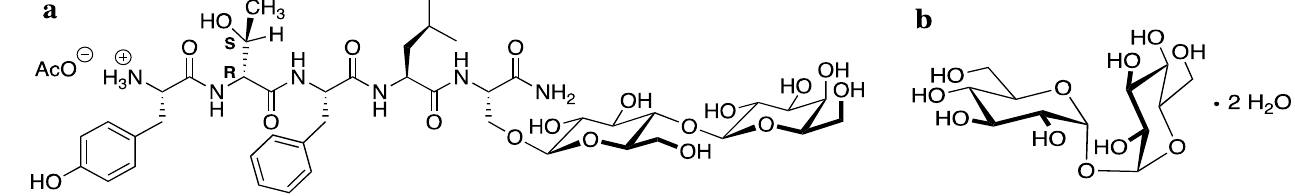
Figure 1. The chemical structures of Lactomorphin/MMP2200 ( a ), and Trehalose dihydrate ( b ). The brain is a unique and complex organ that is highly protected and isolated from the systemic circulation by two major barriers, the BBB and the blood-cerebrospinal fluid barrier (BCSFB) [5]. The BBB’s functional unit includes the capillary endothelial cells, pericytes, and perivascular astrocytes in constant and close contact with the endothelium. These anatomical features and the interaction of these cells support the brain capillary phenotype [5]. The BBB’s endothelial cells are different from the corresponding cells in the periphery in they have minimal pinocytotic activity, increased mitochondrial content, a lack of fenestrations, and the presence of tight junctions [6,7]. The BBB is a barrier for many therapeutics in drug development [8]. The intranasal (IN) route is one of the most promis- ing strategies to deliver drugs non-invasivelyto the brain [8]. Several mechanisms of drug transport through the olfactory epithelium are known and include the transcellular route (i.e., through the cells), the paracellular route (i.e., between the cells), and through the olfac- tory neuronal cells by intracellular axonal transport [9]. The nasal route of administration has many advantages including low dose, higher local bioavailability in the CNS, bypass- ing the BBB, shorter time to drug onset, non- invasiveness, and self-administration [10]. Inhalation aerosol delivery via the respiratory tract to target the CNS non-invasively is an alternative route to injectible drug administration and has unique advantages [11–13]. The lung is a low metabolic organ compared to the gastrointestinal (GI) tract. It allows rapid and high drug absorption due to the large surface area, the high blood flow, and the absence of first-pass metabolism [11,12]. Nasal delivery is represents a viable strategy for treating CNS diseases [14]. Orally inhaled loxapine (Adasuve ® ) is delivered by a novel handheld device (Staccato ® delivery system) to the lungs and was developed for rescue treatment of acute attacks in schizophrenia or bipolar disorder [15]. Inhaled opioids used for pain relief were investigated for several indications such as dyspnea at rest associated with severe heart or lung disease, exercise tolerance, pain after surgery, and the provision of analgesia in general practice